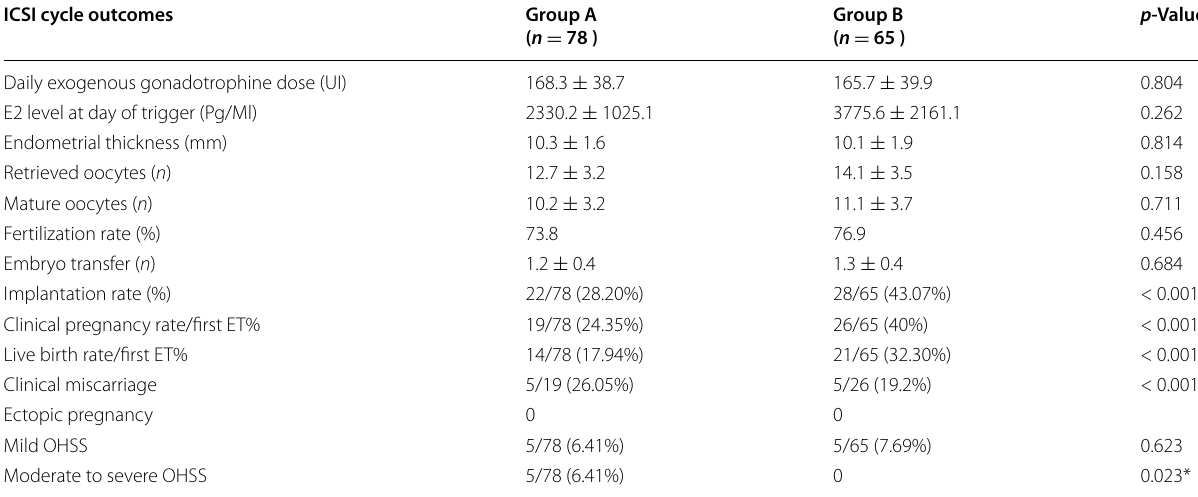
Data are presented as mean (SD), number, and proportion (%). E2 , estradiol; ET , embryo transfer; OHSS , ovarian hyperstimulation syndrome. * P < 0.05 is statistically